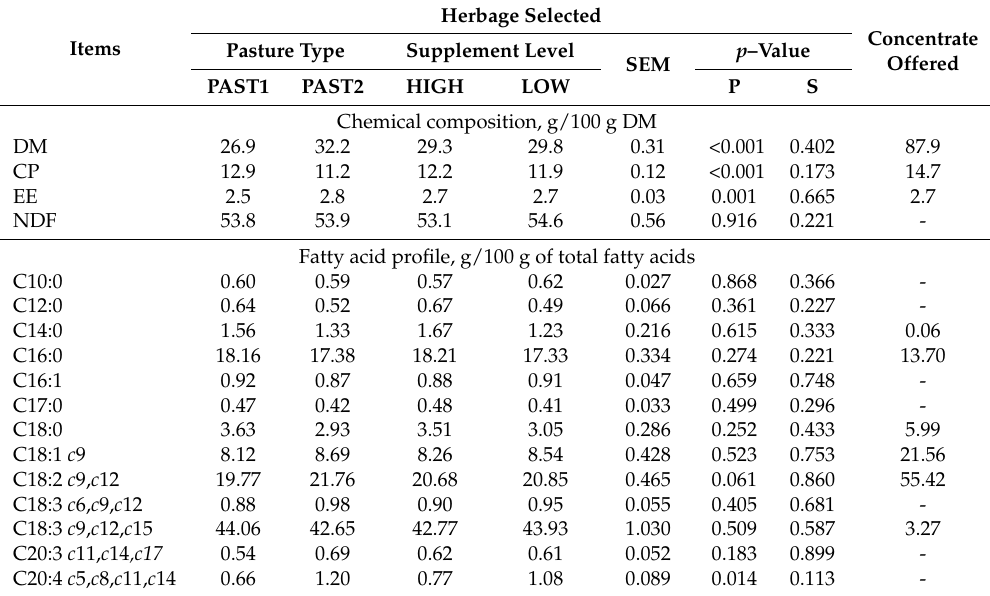
Table 1. Chemical composition and fatty acid profiles of the herbage selected by cows as affected by pasture type and supplement level ( n = 12), and of the concentrate